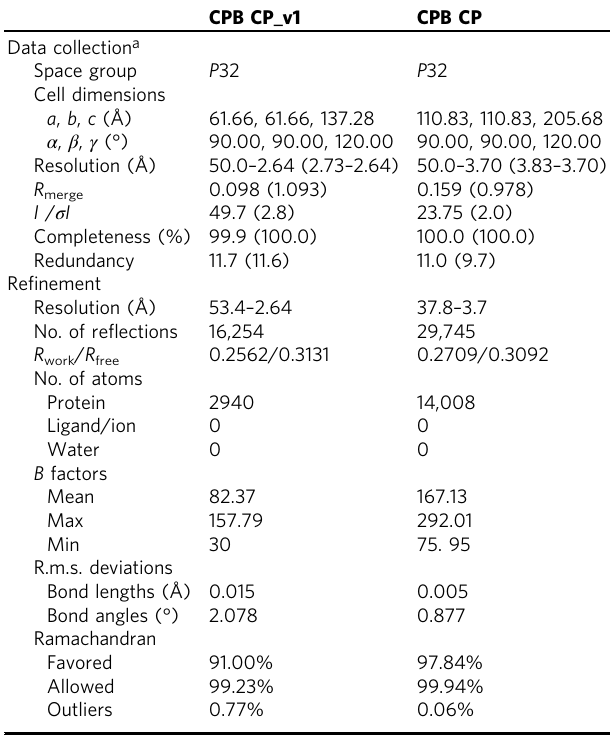
Table 1 Data collection and re fi nement